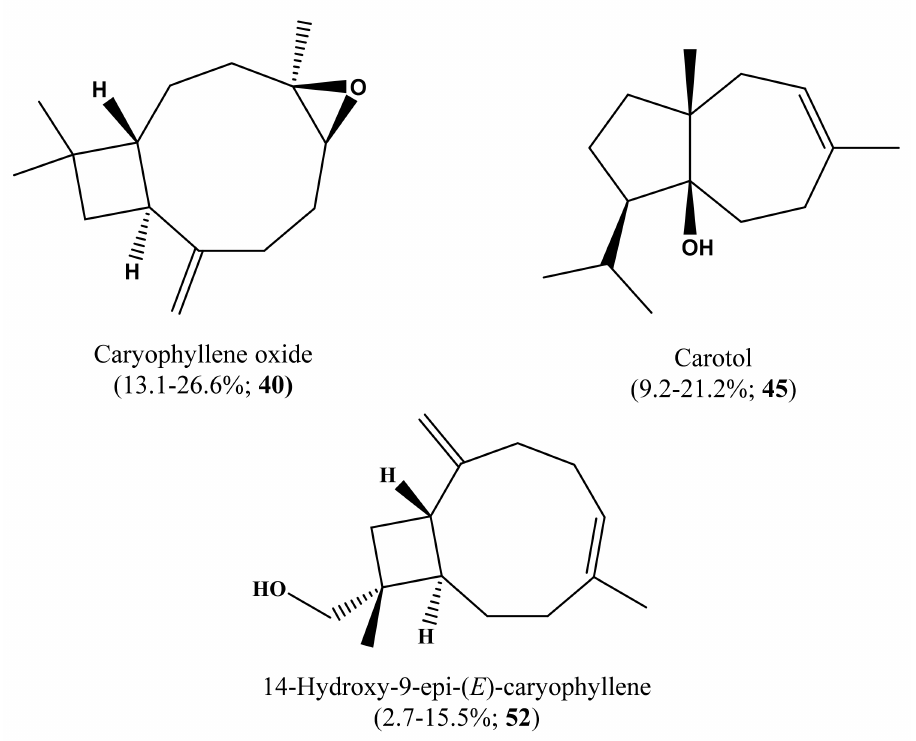
Figure 1. Chemical structures of some major compounds identified in Tetraclinis articulata trunk